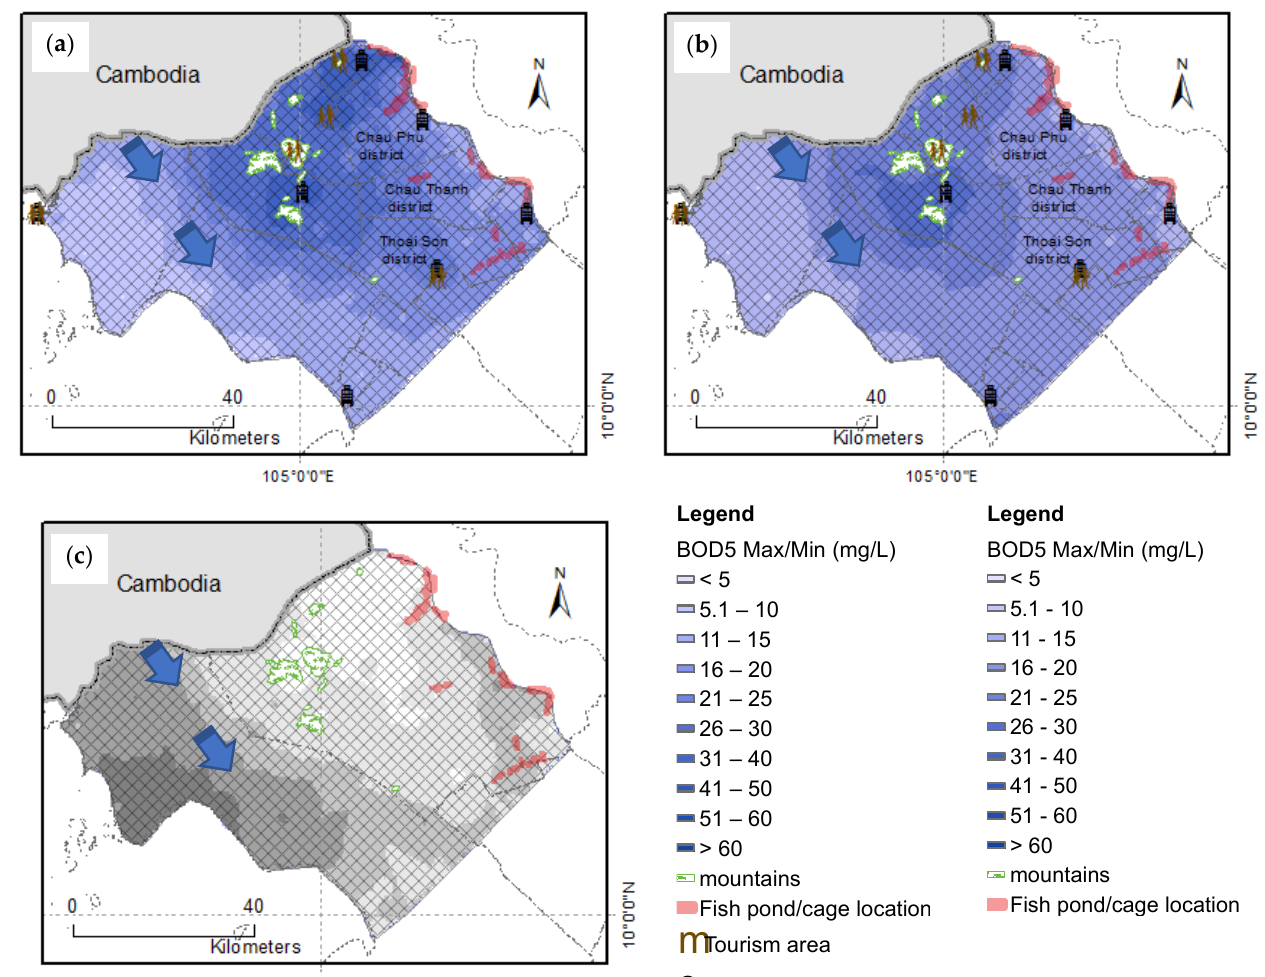
Figure 8. BOD 5 concentration in the dry season of 2020. Here, ( a – c ) represent the maximum, minimum and the difference between the maximum and minimum BOD 5 concentration values, respectively. Moreover, ( a , b ) also show the location of urban and tourism areas, and provincial boundaries. These arrows show the downtrends of BOD 5 concentration ( a , b ) and the downtrends of BOD 5 max–BOD 5 min.